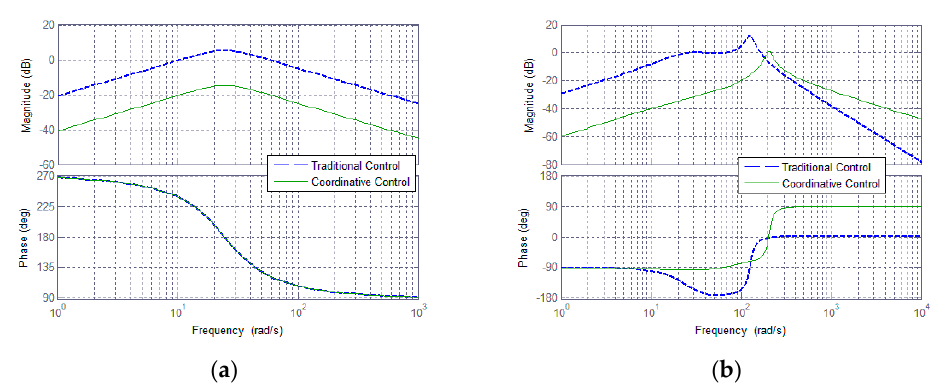
Table 2. The simulation parameters of the SST-based DC microgrid system.